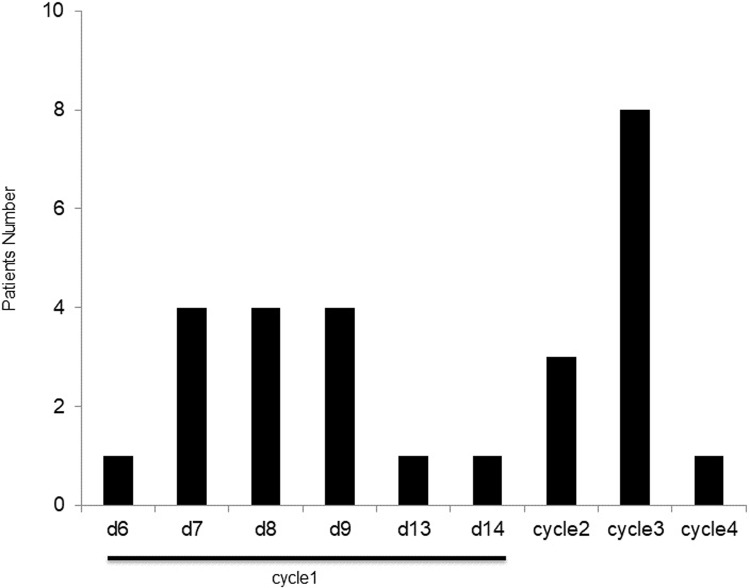
The first febrile neutropenia in DOC group.The bars represent the numbers of patients experienced the first occurrence time of febrile neutropenia in DOC group.